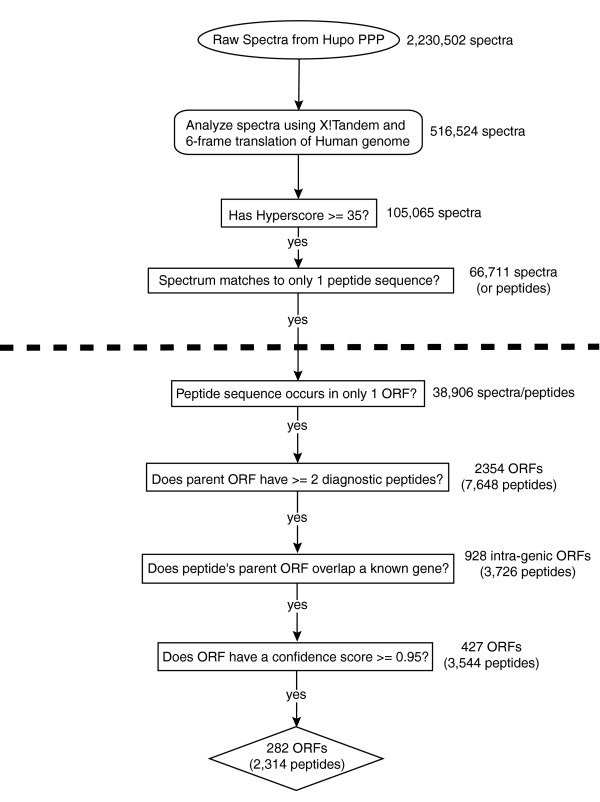
Selection of candidate high confidence ORFs. The flowchart diagrams how high confidence ORFs were identified. Data starts with raw spectra being analyzed by X!Tandem using our six-frame genome translation and ends with our set of high confidence ORFs and the peptides contained within them. The dashed line indicates the switch from discussion of spectra/peptides to ORFs.